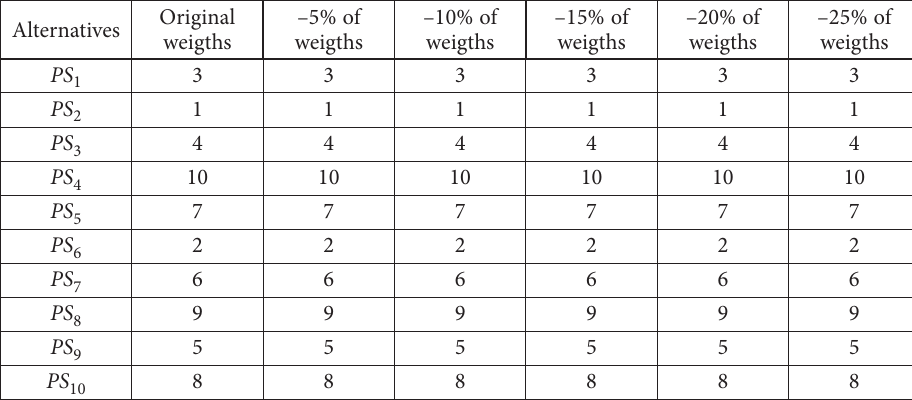
Table 5. Ranking of results (i.e., sorting of alternatives) according to the variation in the weights as- signed to the different criteria